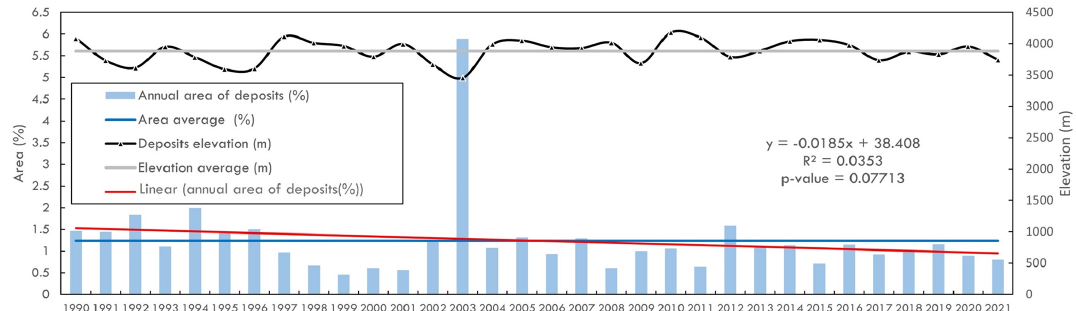
Figure 10. Snow avalanche depositional zone area and elevation trends since 1990 in the Amu Panj basin. Elevation was calculated within each polygon of avalanche deposits using SRTM-30 digital elevation model. A Mann–Kendall test ( p -value 0.05) was conducted to assess the significance of the